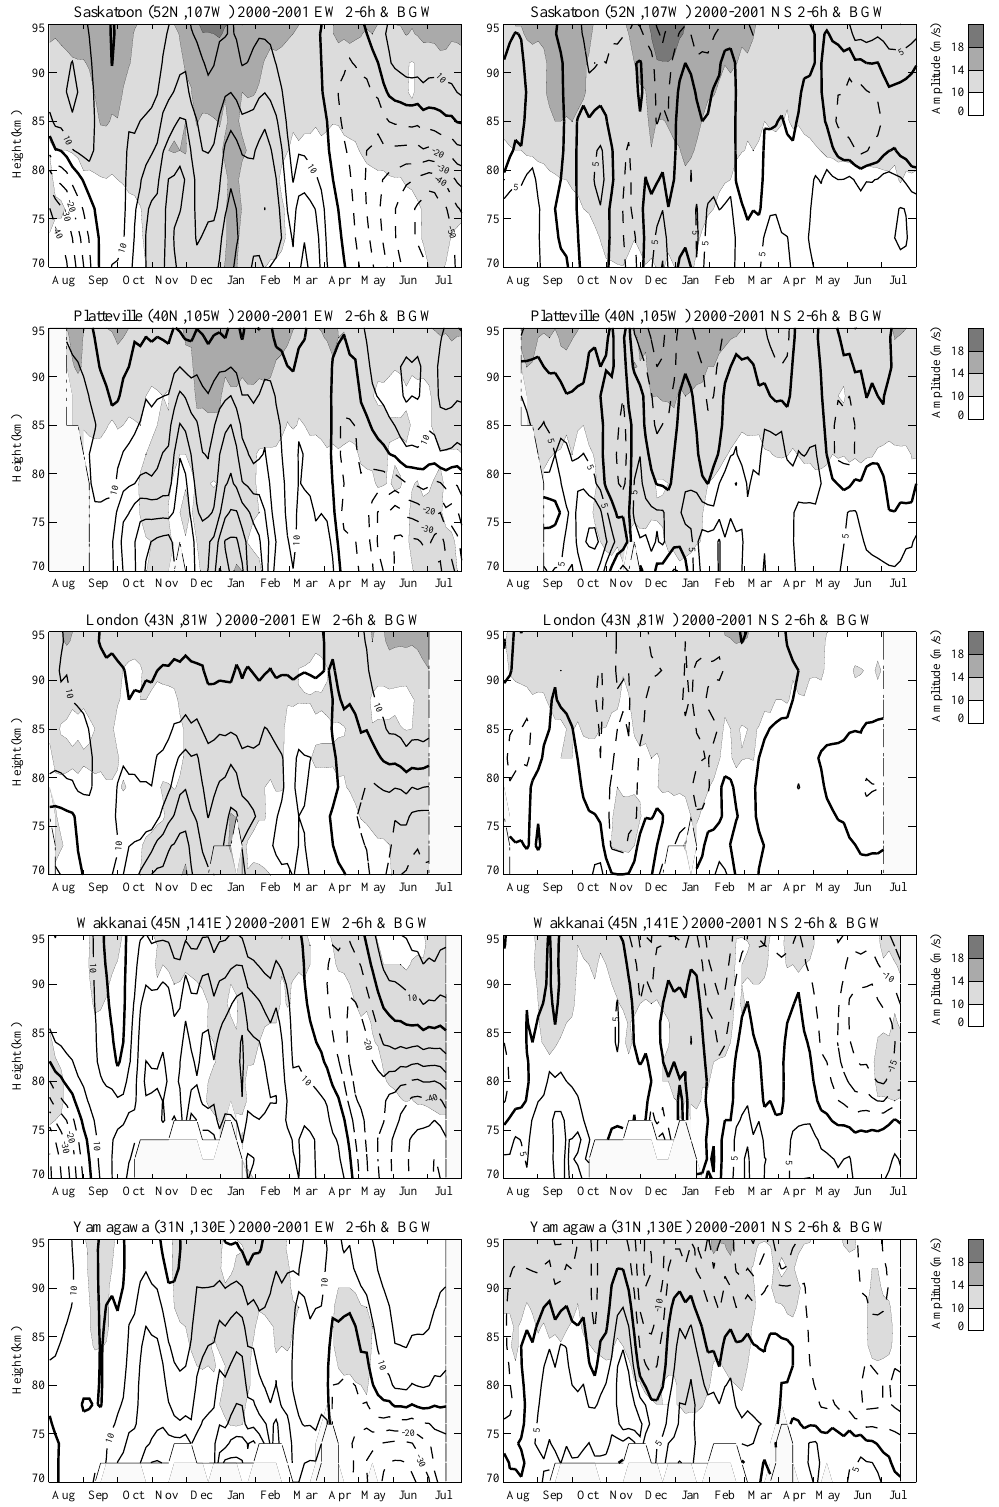
Fig. 9. Annual contours of wave amplitudes as functions of height versus time for the zonal and meridional (EW, NS) components of GWs (2–6h): plots for Saskatoon, London, Platteville, Wakkanai and Yamagawa are shown. The mean winds (background) are indicated by continuous or dashed